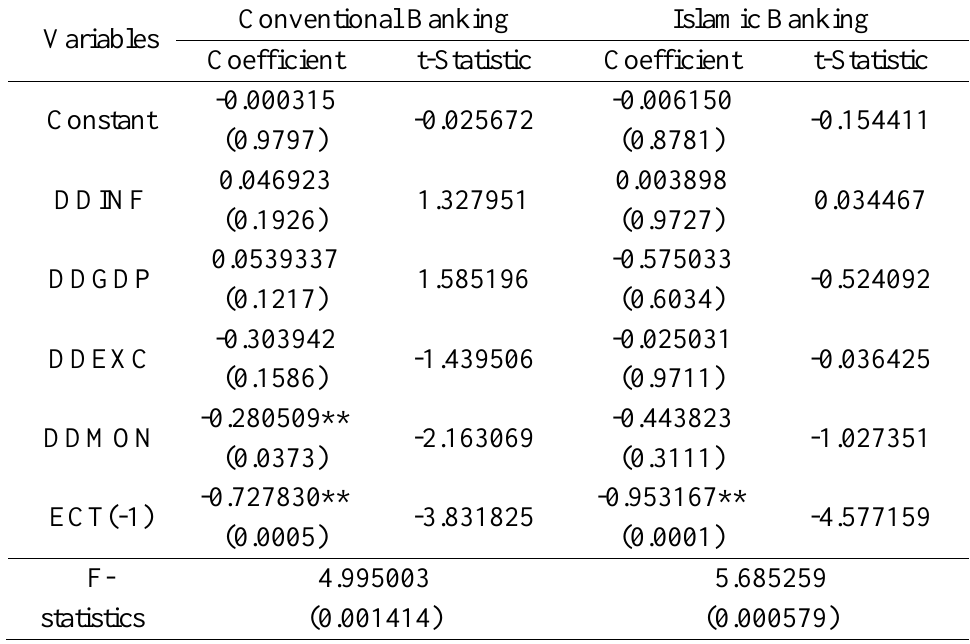
Table 6. Short-Term